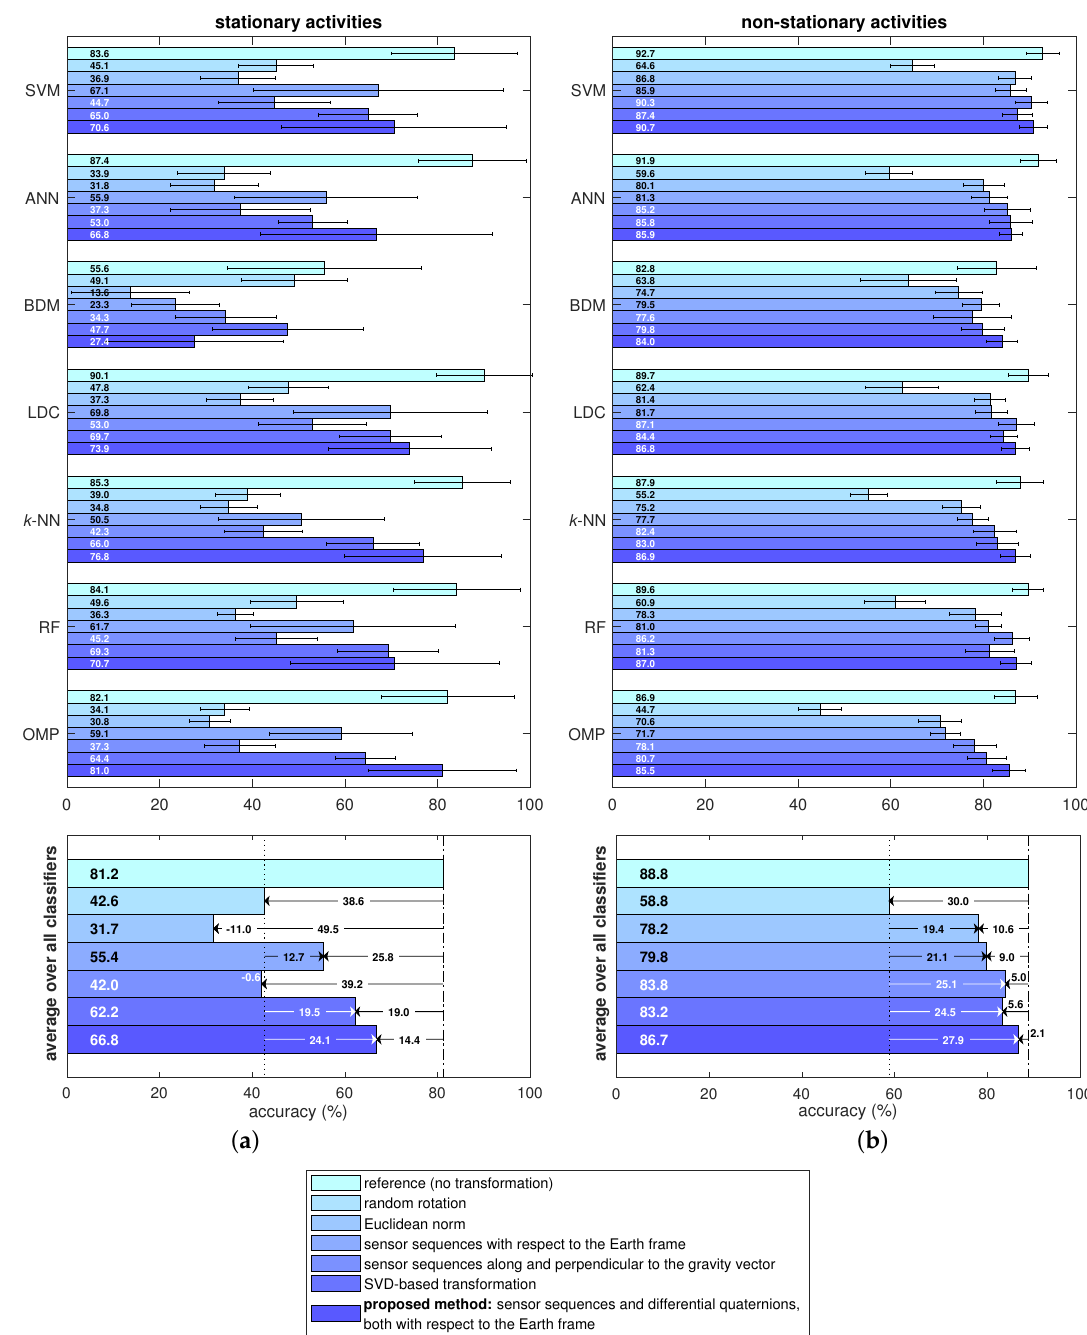
Figure 10. Activity recognition performance for all the data transformation techniques and classifiers for ( a ) stationary and ( b ) non-stationary activities. The lengths of the bars represent the accuracies and the thin horizontal sticks indicate plus/minus one standard deviation over the cross-validation